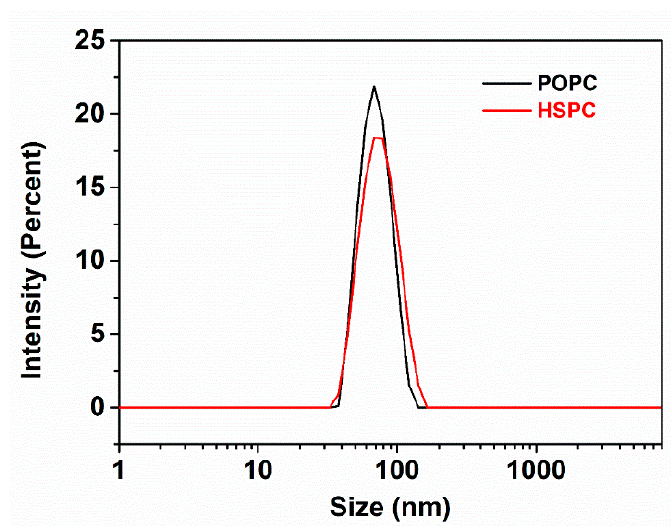
Figure 2. Size distribution of HSPC and POPC SUVs in water determined by dynamic light scattering (DLS). The hydrodynamic size and polydispersity index (PDI) for HSPC and POPC SUVs in water are 73 ± 6 nm (PDI = 0.071 ± 0.015) and 68 ± 5 nm (PDI = 0.056 ± 0.021), respectively.